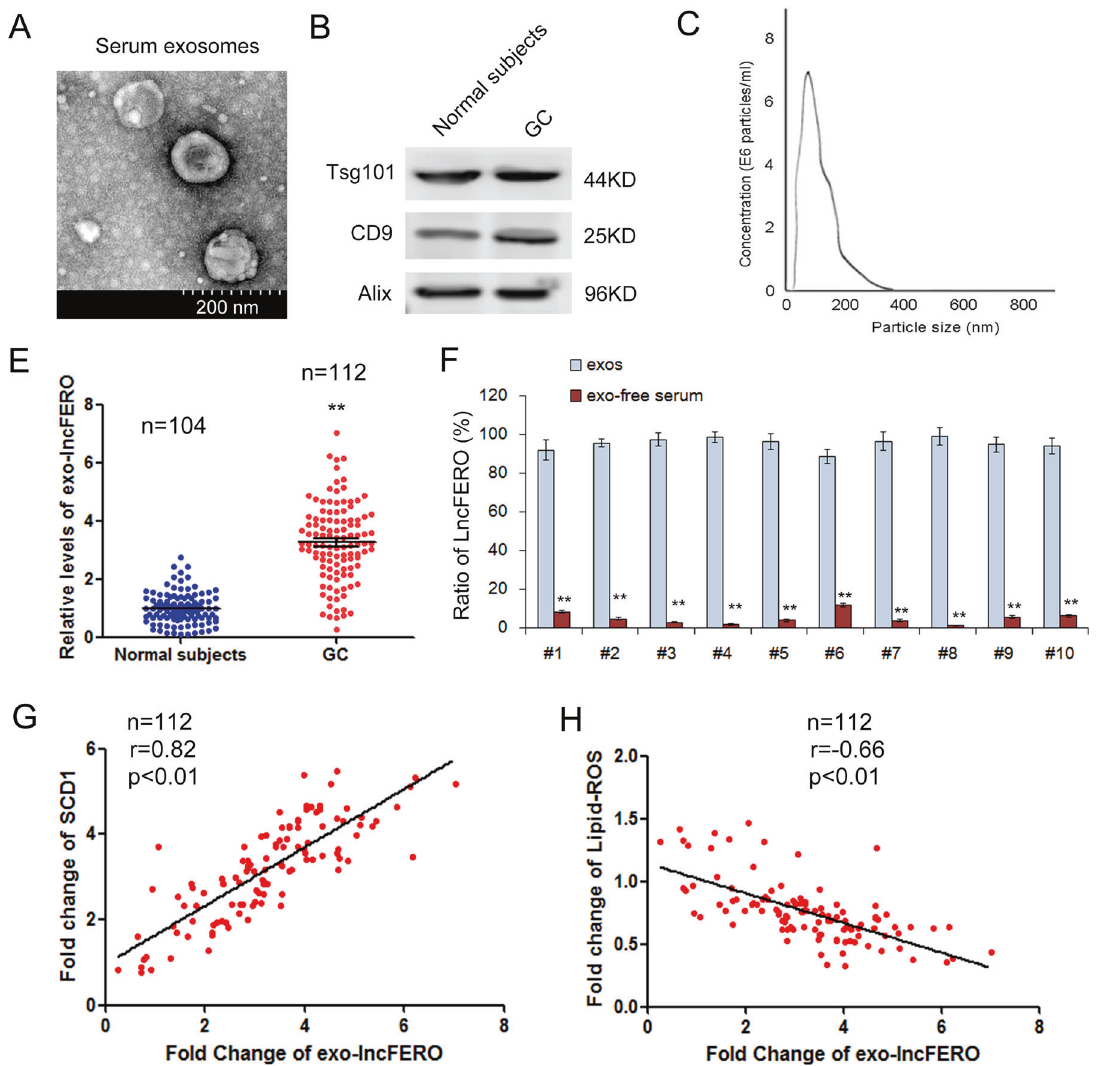
Fig. 2 Exosomal lncFERO is positively linked with SCD1 expression. A Serum exosomes were observed by using an electron microscope (scale bar, 200 nm). B Detection of exosome markers, Tsg101, CD9, and Alix, by western blotting assay. C Nanotracking analysis of the diameters of vesicles. E Relative levels of exo-lncFERO in normal subjects ( n = 104) and GC patients ( n = 112). F Relative levels of exo-lncFERO in the exos and exo-free serum ( n = 10). G Exo-lncFERO is positively correlated with SCD1 ( n = 112). H Exo-lncFERO is negatively correlated with lipid ROS levels ( n = 112). ** p <